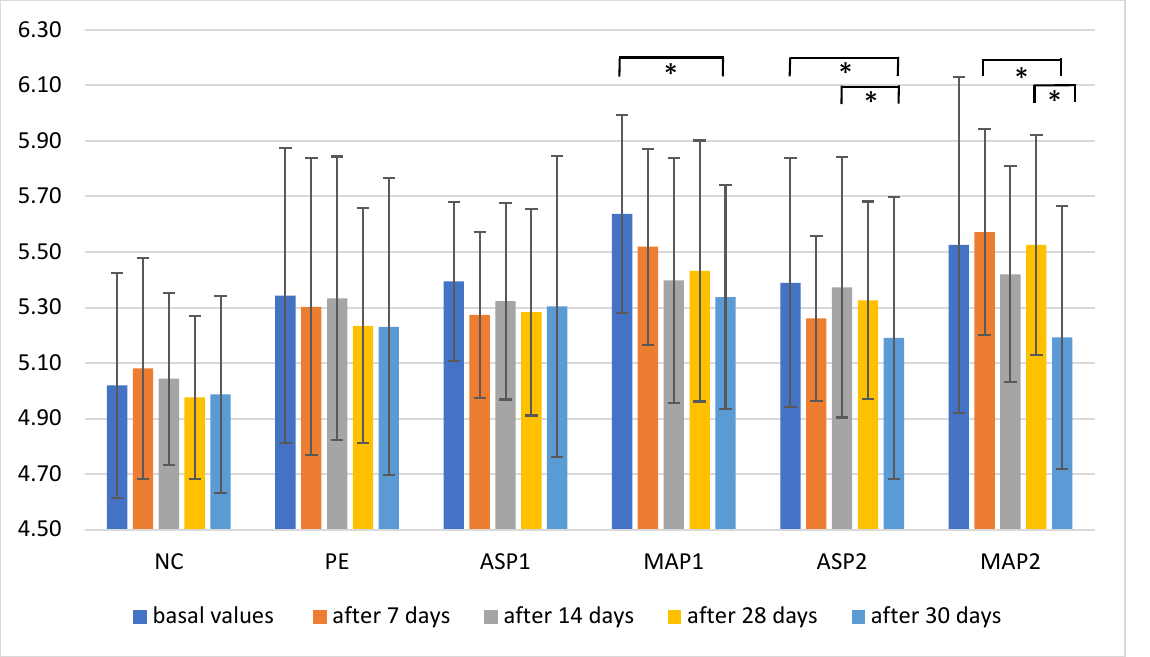
Figure 2. In vivo determined mean values with standard deviation of pH for non-treated control (NC), placebo emulgel (PE), and the investigated emulgels (ASP1, MAP1, ASP2 and MAP2) after 7, 14, and 28 days of application, and 2 days after the cessation of application. Significant differences are marked with * ( p < 0.05).